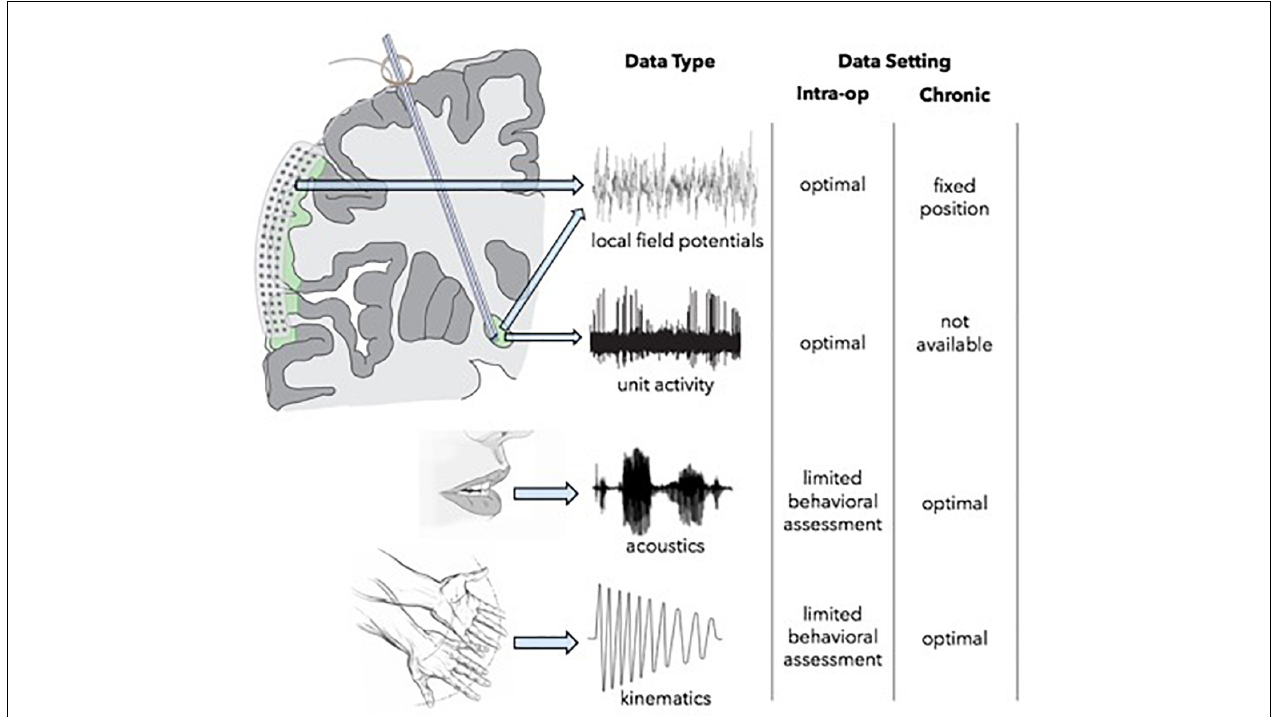
FIGURE 3 | Intracranial neurophysiology opportunities for network